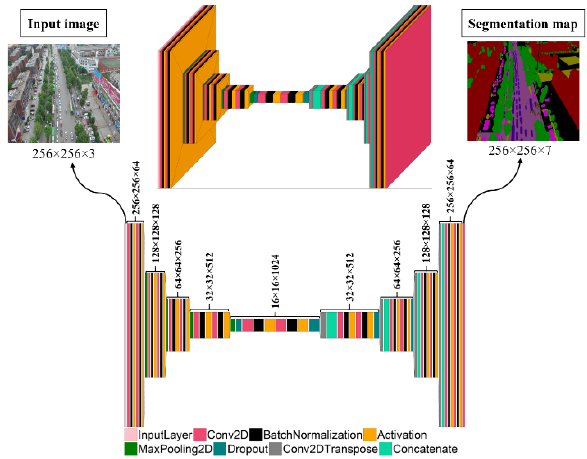
Figure 2 . U-Net architecture (dimensions of input images 256×256×3 and dimensions of output segmentation